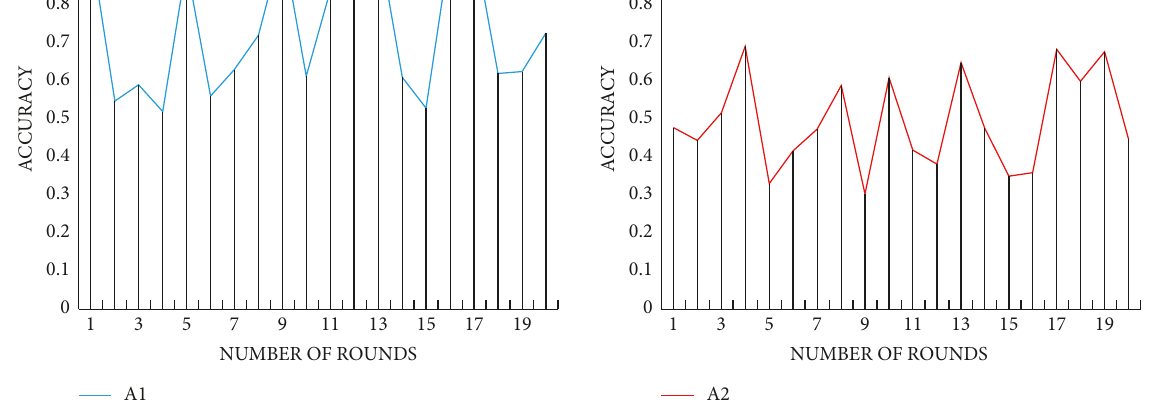
Figure 7: Sorting effect comparison.